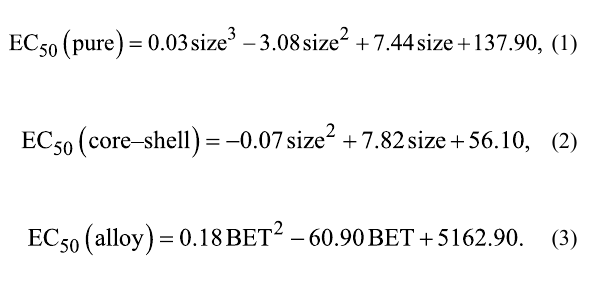
second-order for alloys and core–shell systems, with R 2